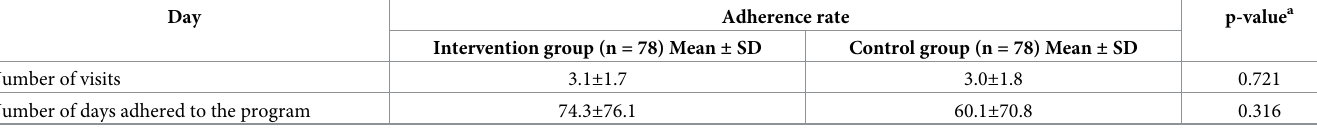
Table 7. Adherence rate to the smoking cessation program in the intervention and control groups.